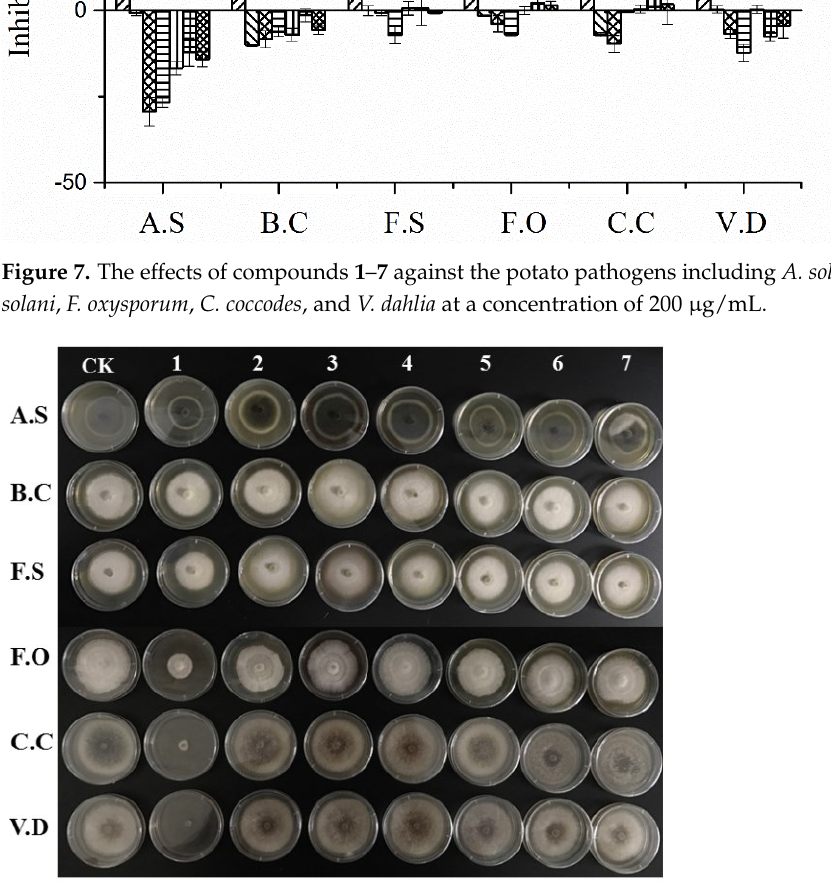
Figure 8. Typical pictures of the effects of compounds 1 – 7 against potato pathogens including A. solani , B. cinerea, F. solani, F. oxysporum , C. coccodes , and V. dahlia at a concentration of 200